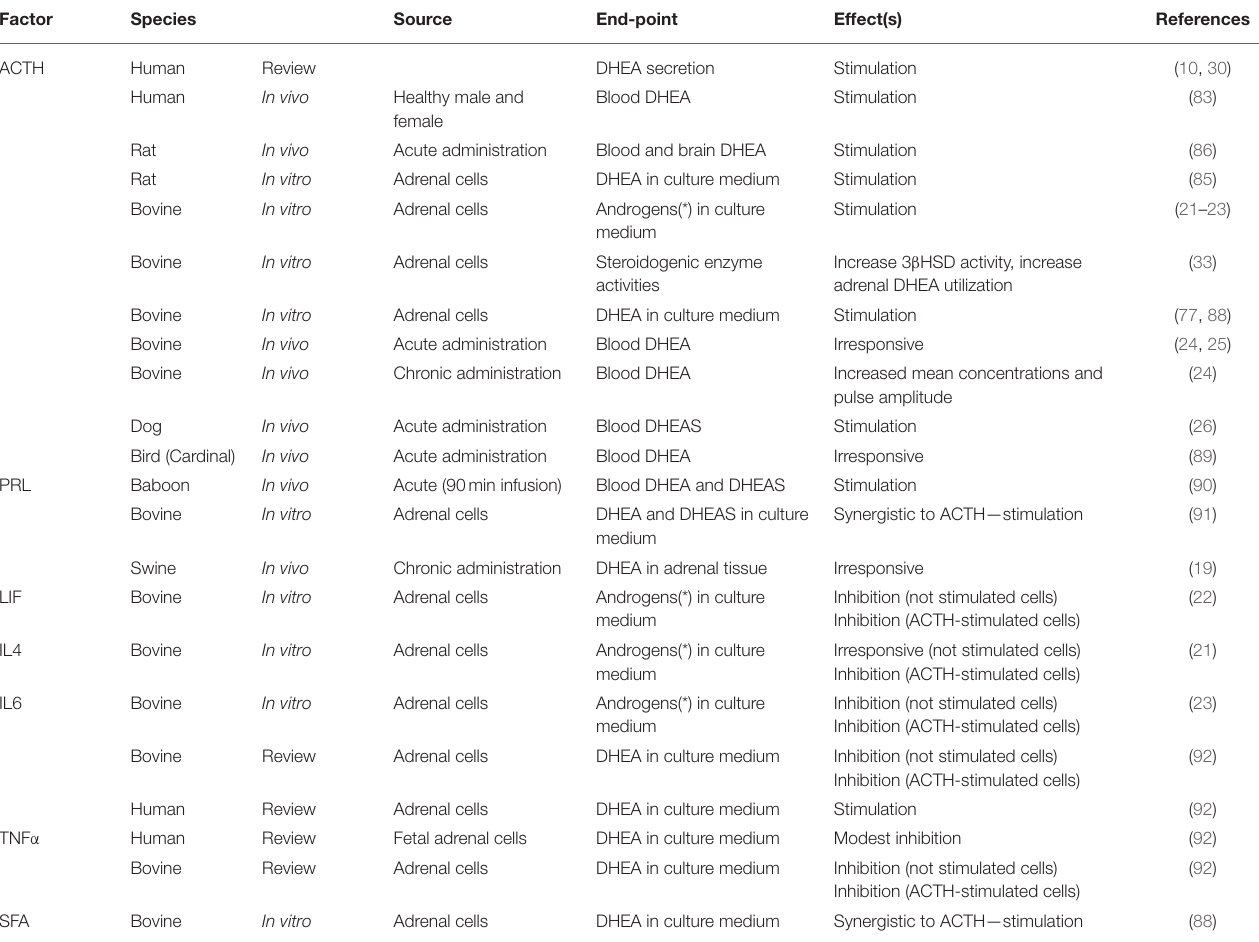
TABLE 1 | Hormones and cytokines involved in the regulation of adrenal DHEA/DHEAS synthesis.